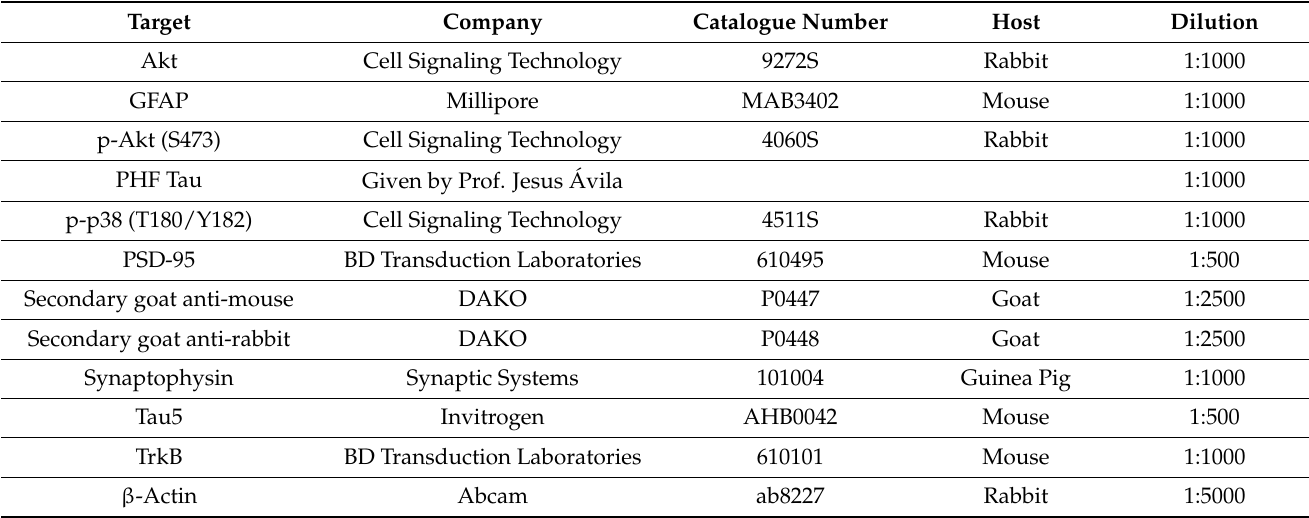
Table 1. List of antibodies used in Western blot